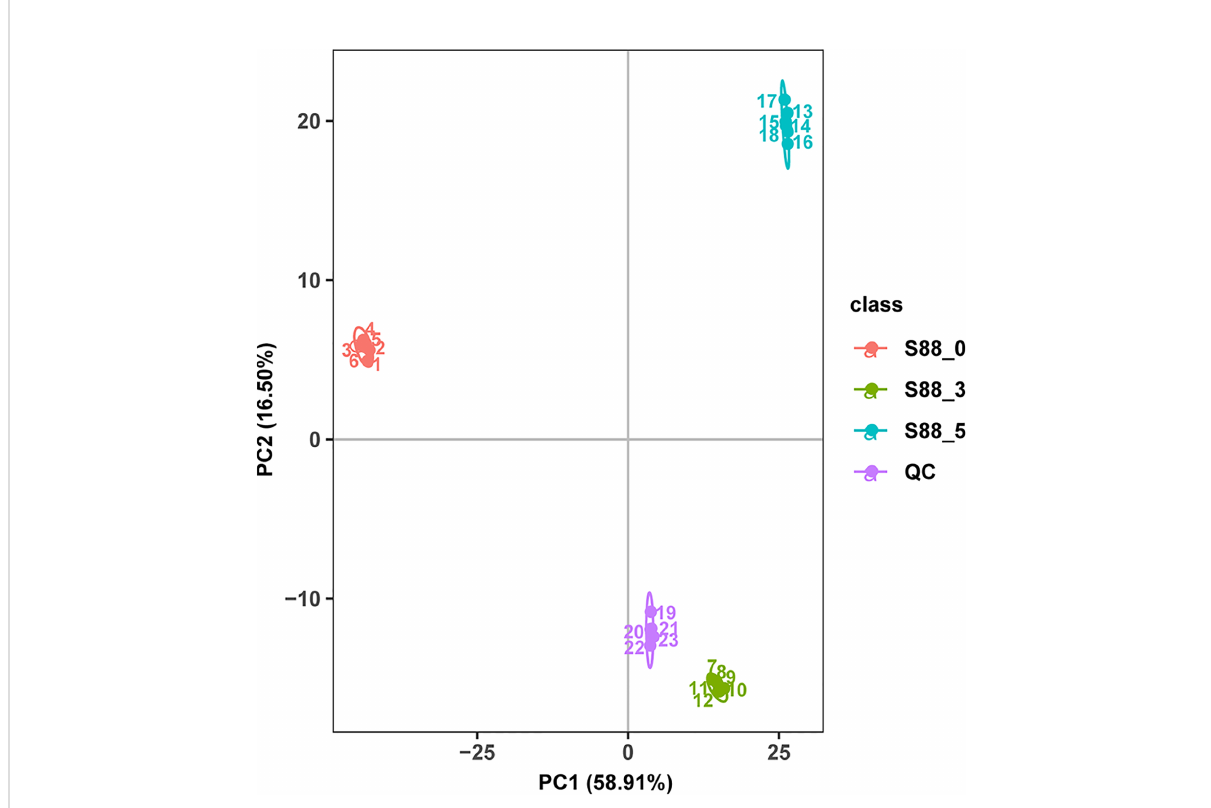
FIGURE 3 PCA score of different metabolites and the correlation analysis of QC samples. The three samples under three inoculation time points of F. fujikuroi were named as S88_ 0, S88_ 3, and S88_ 5, respectively. The six biological replicates corresponding to each sample were named S88_ 0_ a, S88_ 3_ a, and S88_ 5_ a, respectively, where a ∈ {1, 2, 3, 4, 5,